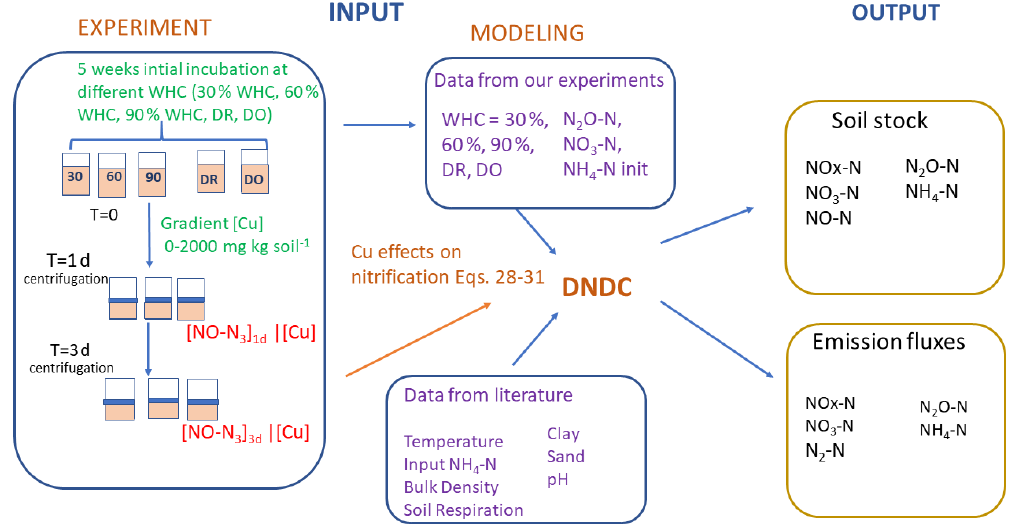
Figure 1. Schematic representation of the experimental and modelling procedures. Left refers to the experimental part and centre to right to the modelling part. Soils were first incubated 5 weeks at different constant percentages of the water holding capacity (WHC) or at two variable moisture levels, Dry-Only (DO) and Dry-Rewet (DR). Then NO 2 -N, NO 3 -N and NH 4 -N soil concentrations were measured after this initial incubation, and values were used to initialise DNDC, while a bioassay was also applied to soil aliquots. The 3d bioassay included NH + in excess and copper (Cu) spikes at 0, 50, 100, 250, 500, 750, 1000 and 2000mgCukg soil − 1 of soil. After 1 and 3d of bioassay 4 incubation, NO 3 -N production was measured in the supernatant. NO 3 -N productions against [Cu] gradients were used to define the functions of Eqs. (28) to (31) in Sect. 3.1 (see text). Soil respiration values were extracted from the curve C i of Fig. 1 in Annabi et al.